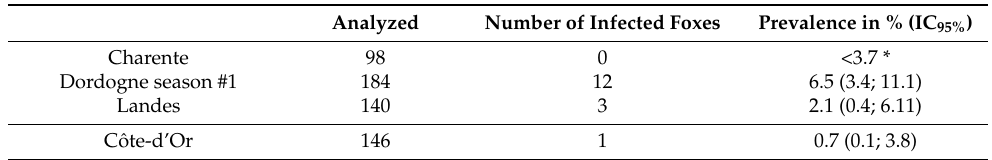
Table 1. M. microti infection of foxes in three TB areas of Nouvelle-Aquitaine and in the core TB infected area of C ô te-d’Or, France.